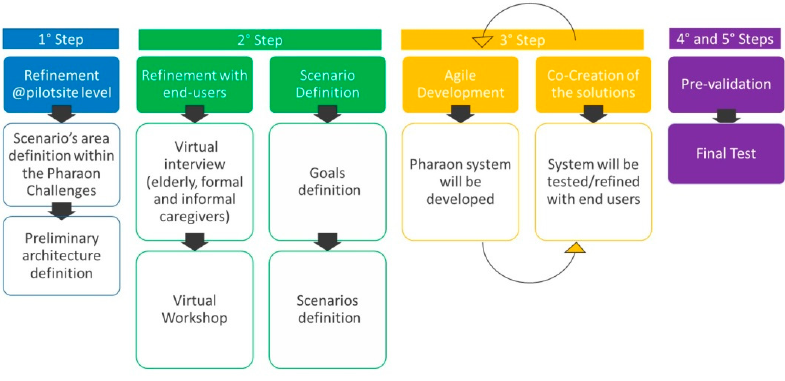
Figure 1. Overview of the PHArA-ON methodology applied at Italian Pilot level. Table 2. Overview of system